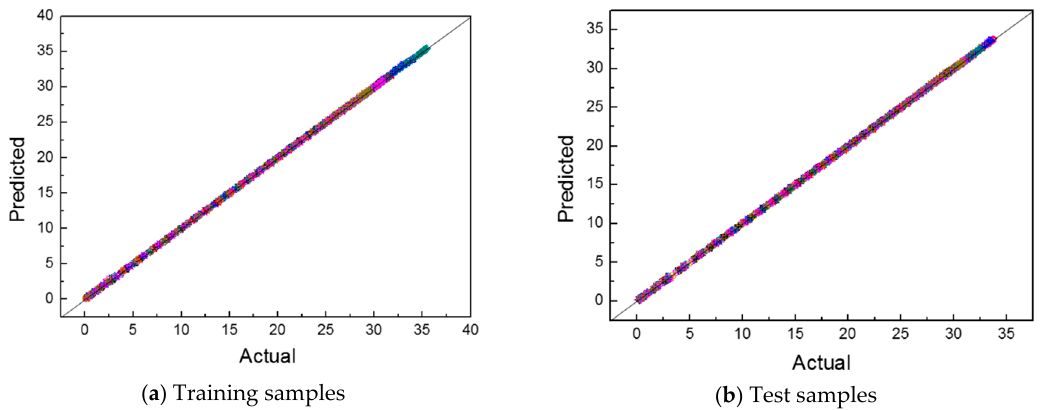
Figure 15. Actual–predicted z-displacement plot for 40 samples. ( a ) Training samples; ( b ) Test samples.